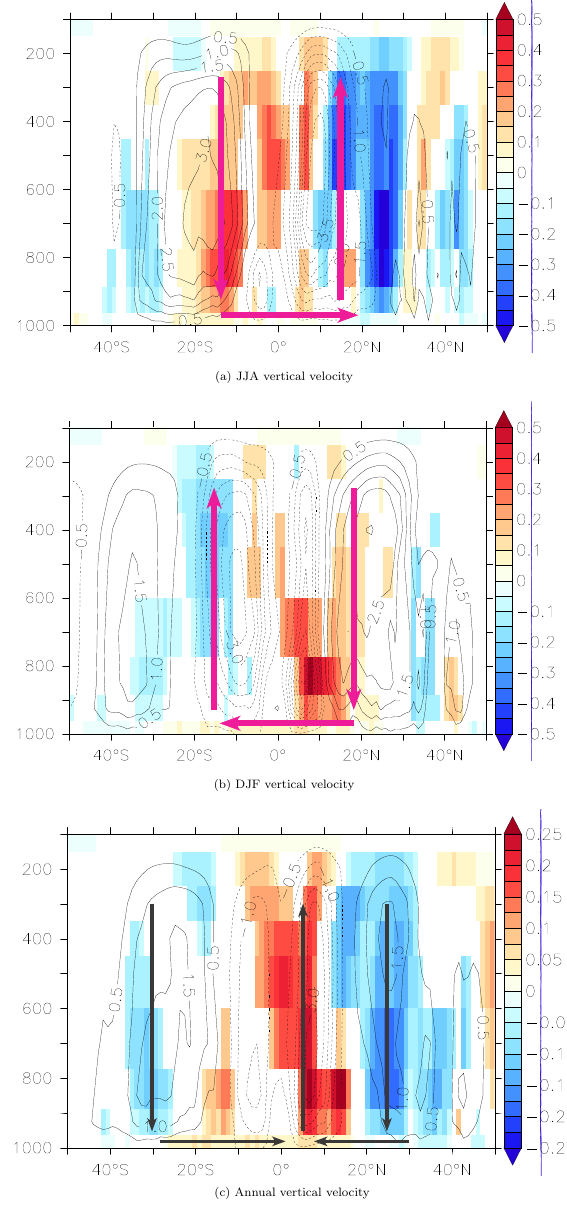
Figure 8. Zonal mean vertical velocity (omega, 10 − 2 Pas − 1 ) dur- ing T max (contours) for JJA (a) , DJF (b) and annual mean (c) . Neg- ative contours indicate upward motion (rising air), while positive contours indicate downward motion (sinking). The vertical scale ( y axis) denotes height in hPa. The colours indicate the differences between T max and T min , only shown where they are statistically sig- nificant at 95% (based on a two-sided Student t test). The arrows indicate the direction of the air flow and are purple where the flow is stronger during T max compared to T min , which is the case for boreal and austral summer (a, b) . Black arrows indicate where the flow is weaker during T max . Hence the Hadley cell is stronger during T max in both boreal and austral summer, and weaker in the annual mean. Note the different colour scale for the annual